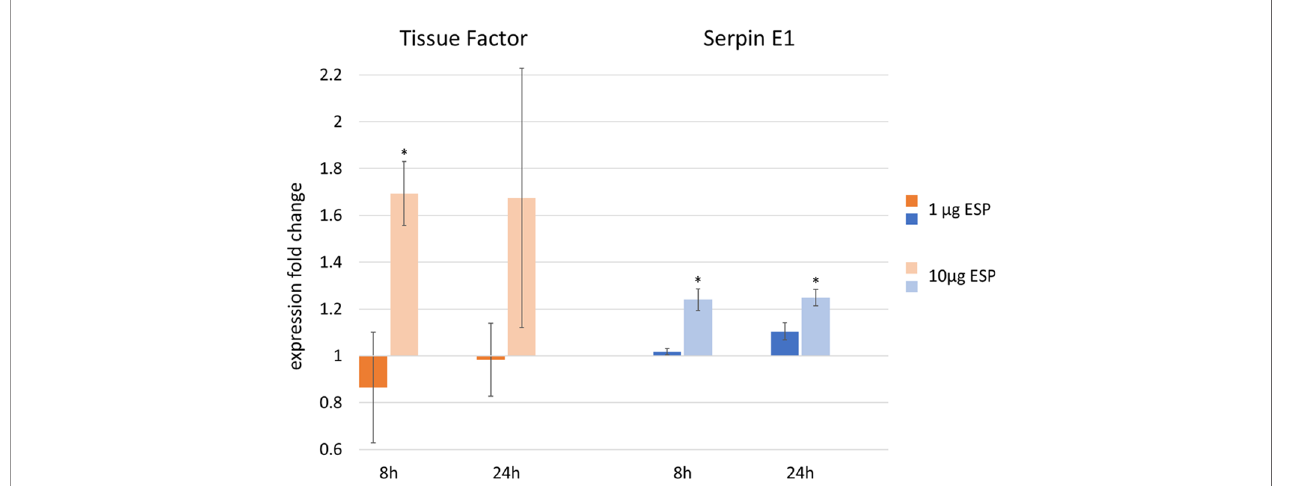
FIGURE 8 | Upregulation of tissue factor (TF) and serpin E1 mRNA expression, as measured by qRT-PCR in canine endothelial cells after stimulation with 1 ng tumor necrosis factor a (TNF a ) and 1 m g or 10 m g Angiostrongylus vasorum excretory/secretory proteins (ESP) incubated for 8 or 24 h (data based on 3 replicates). Cells stimulated with 1 ng TNF a only represent the control values of 1. * p < 0.05, One-Way ANOVA Tukey ’ s post